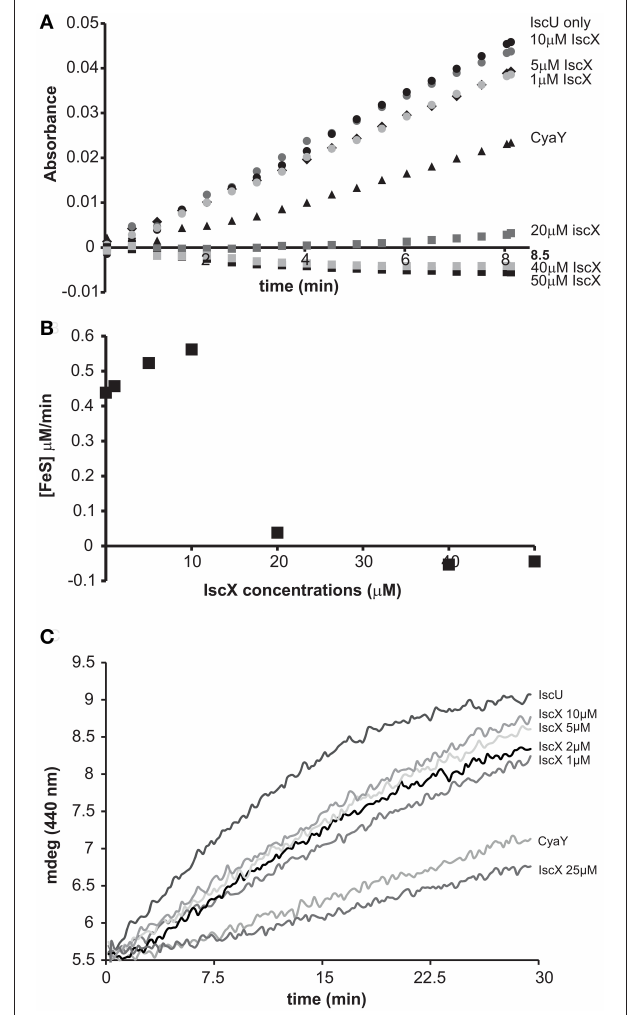
FIGURE 1 | Effect of increasing concentrations of IscX on the enzymatic kinetics of Fe-S cluster formation on IscU. (A) Kinetics of cluster formation at increasing concentrations of IscX as measured by absorbance at room temperature. (B) Plot of the initial rates at increasing concentrations of IscX. Negative values are due to imperfect subtraction from the baseline and should be considered as zero (full inhibition). Only the initial part of the kinetics for each IscX concentration point was considered. The slope of these linear regions (for each IscX concentration) was used as the initial velocity. A molar extinction coefficient of 10.5 mM − 1 cm − 1 was assumed to convert the absorbance in concentration of Fe-S cluster produced. (C) Kinetics followed by CD. The assays were carried out using 1 µ M IscS, 50 µ M IscU, 250 µ M Cys, 2mM DTT, and 25 µ M Fe 2 + and increasing concentrations of IscX as indicated. For comparison, the experiment was also repeated in the presence of 5 µ M CyaY. The error bars are not shown for sake of clarity but were typically within 5% or